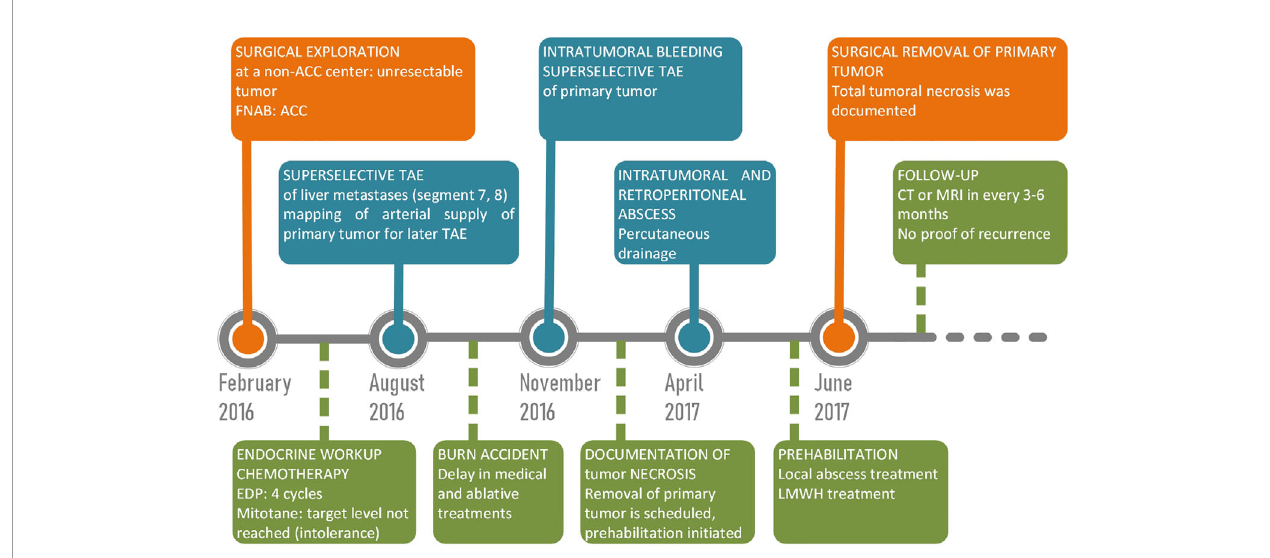
FIGURE 2 | Timeline of case.